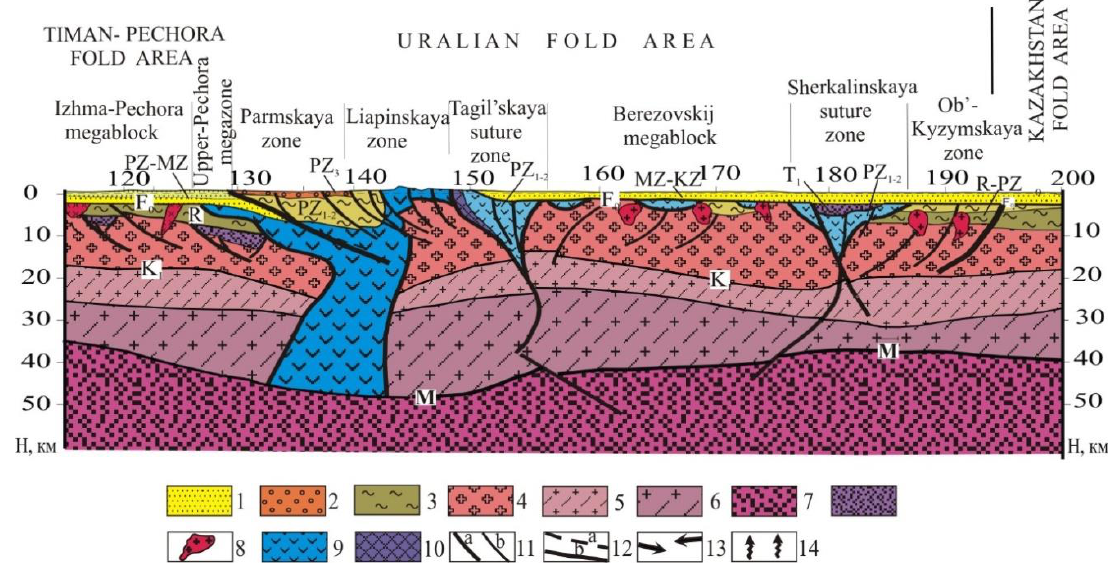
Figure 8. Section of the Earth’s crust of the Ural fold zone (fragment of the “Murmansk-Kyzyl” geo-traverse). Compiled using materials from the Center GEON and VSEGEI. See Figure 2 for legend.